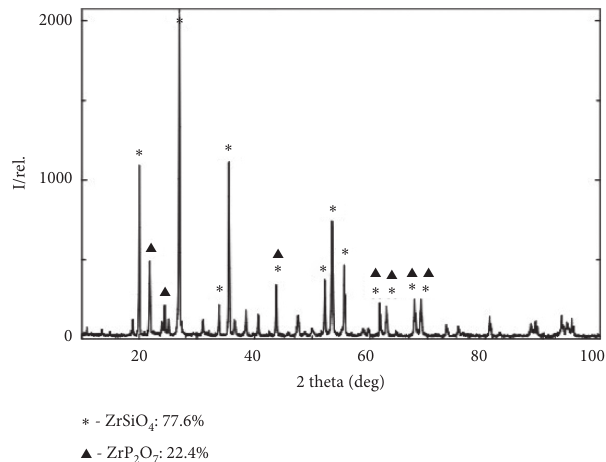
Figure 3: X-ray analysis of the composition of dust zircon (5 mass units) and H 3 PO 4 (3 mass units), strengthened at 300 ° S .